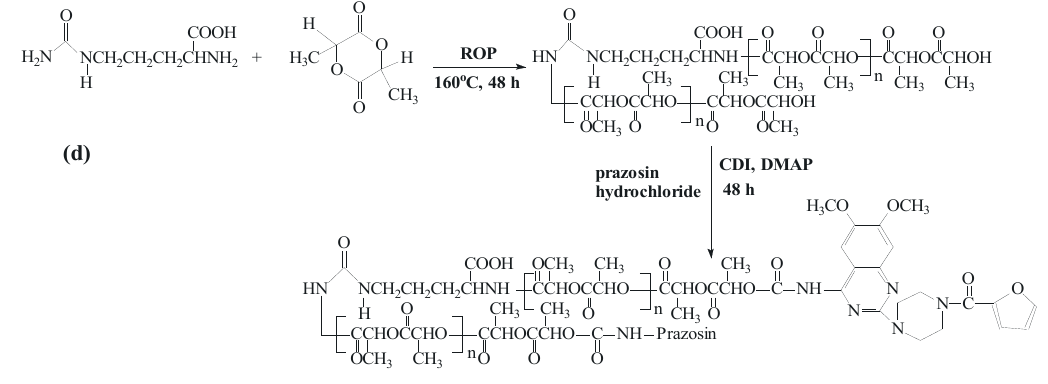
Scheme 1. Synthesis of the biodegradable macromolecular conjugates of prazosin